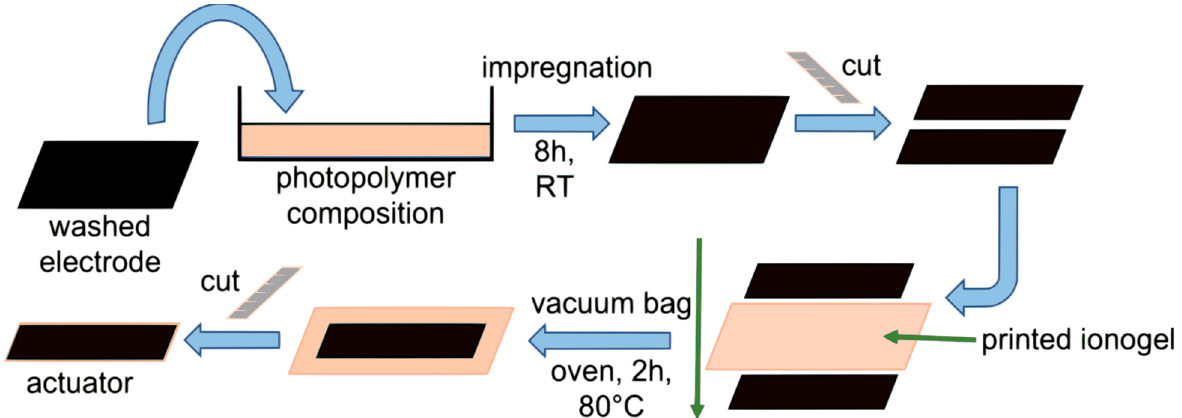
Figure 4. Manufacturing scheme for actuators.